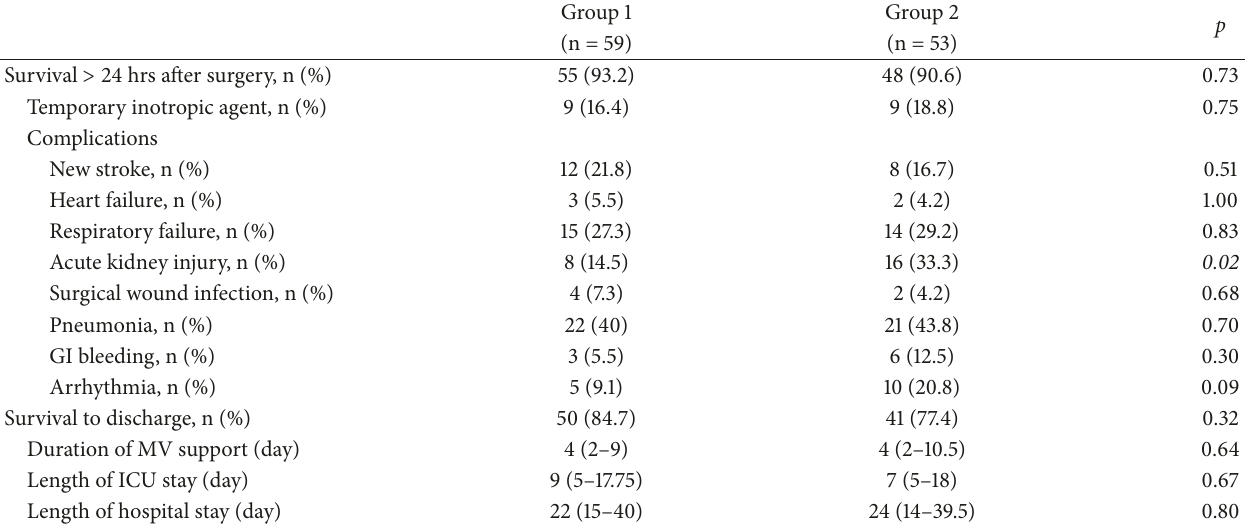
Table 4: Postoperative